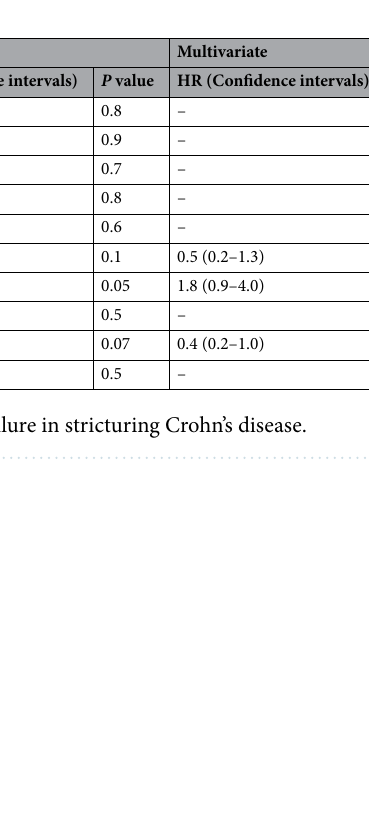
Table 4. Adverse events secondary to